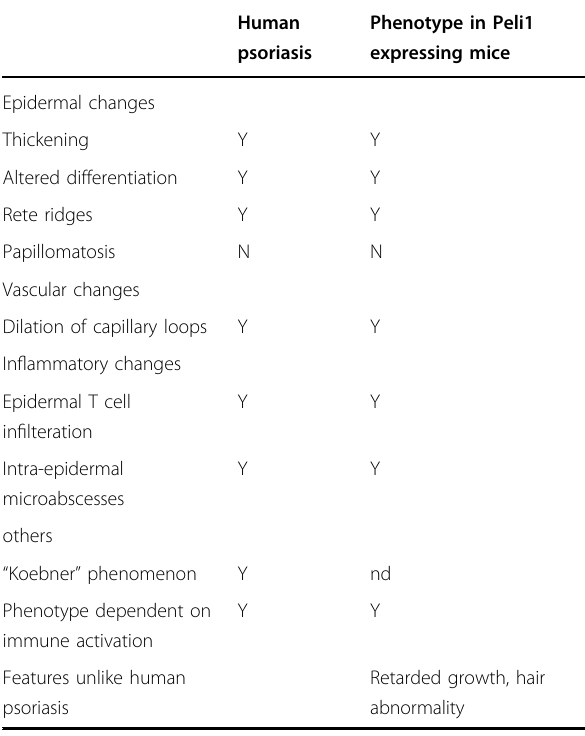
Table 1 Comparison of pathological phenotype similarity between human psoriasis and Peli1 expressing